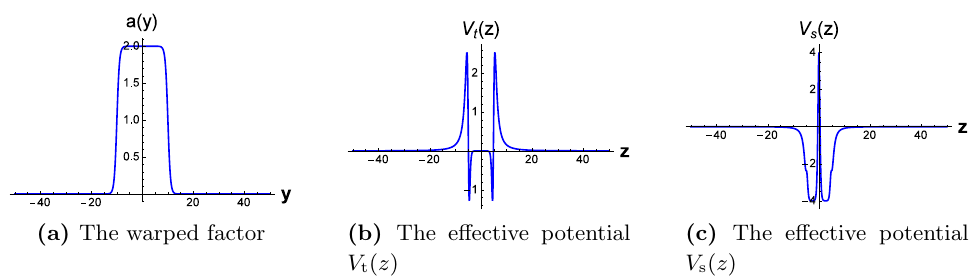
Figure 1. The shapes of the warp factor a ( y ) and the e(cid:11)ective potentials V t ( z ) ; V s ( z ) for the single brane model (3.1). The parameters are set to k = 1 and b =